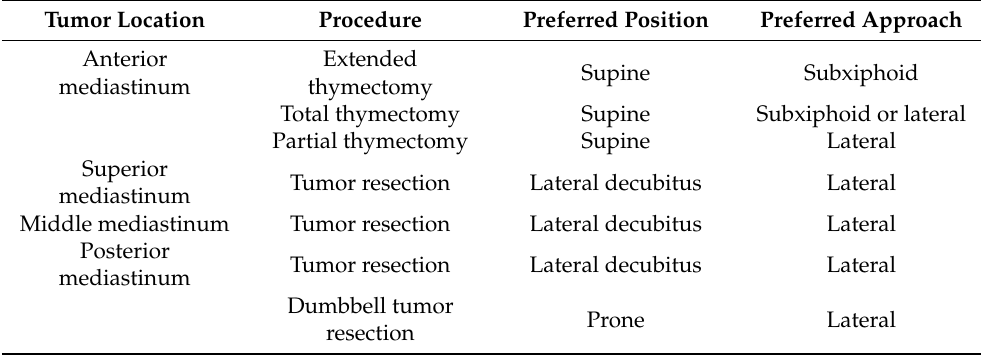
Table 3. Preferred position and approach for RATS mediastinal tumor resection according to tumor location and surgical